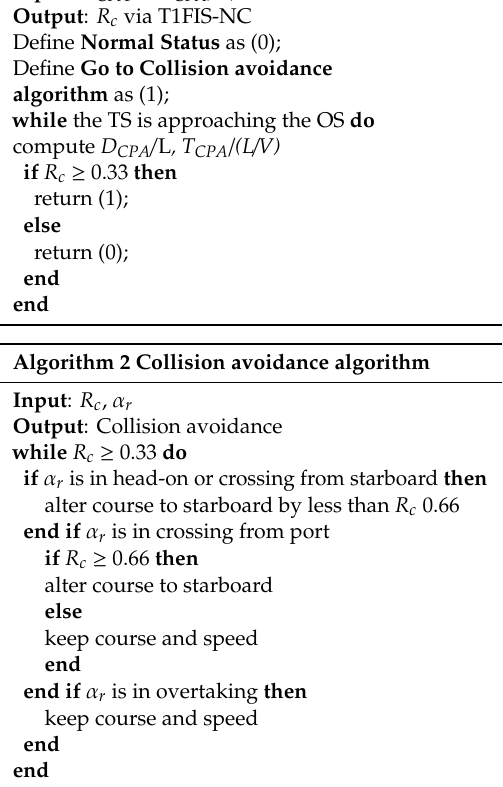
Algorithm 1 Risk algorithm